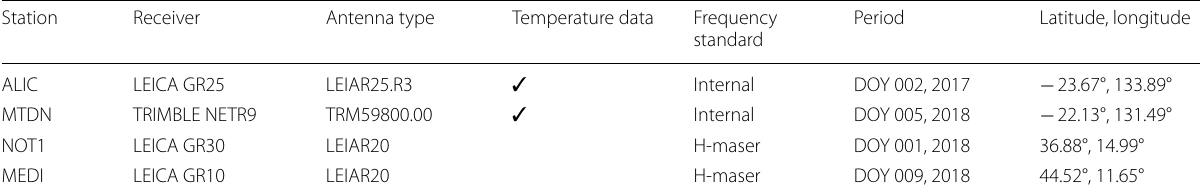
Table 1 The information on the collected GPS data used in this